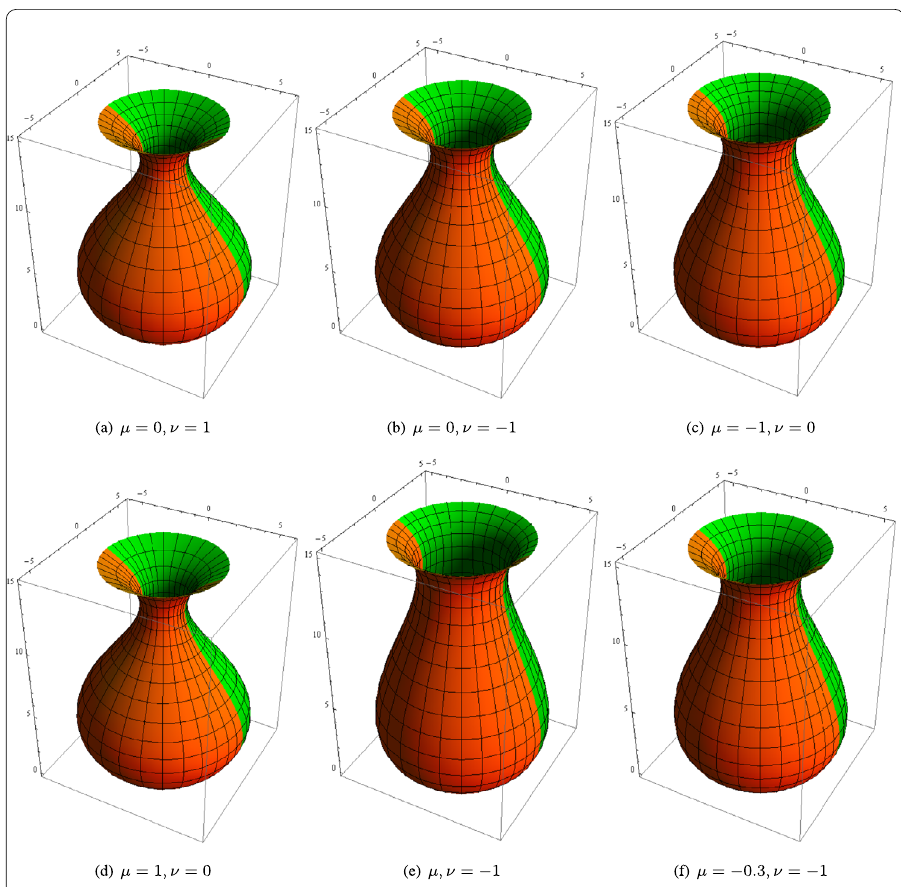
Figure 21 GBT-Bézier rotation surfaces with a variety of shape control parameters